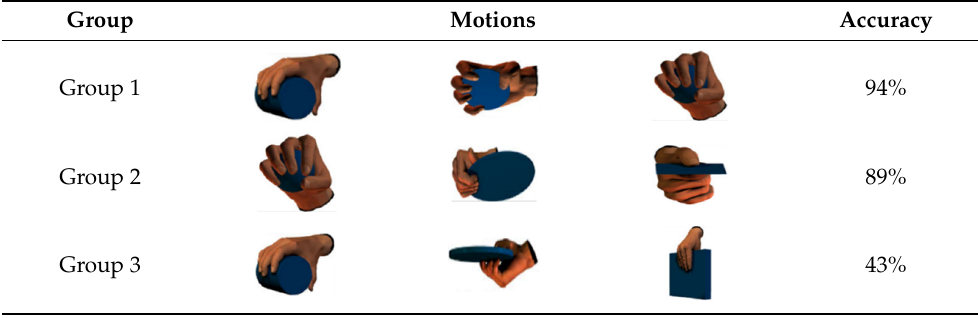
Table 3. Classification accuracy of three groups of hand grasping motions for CNN-based prediction and control.